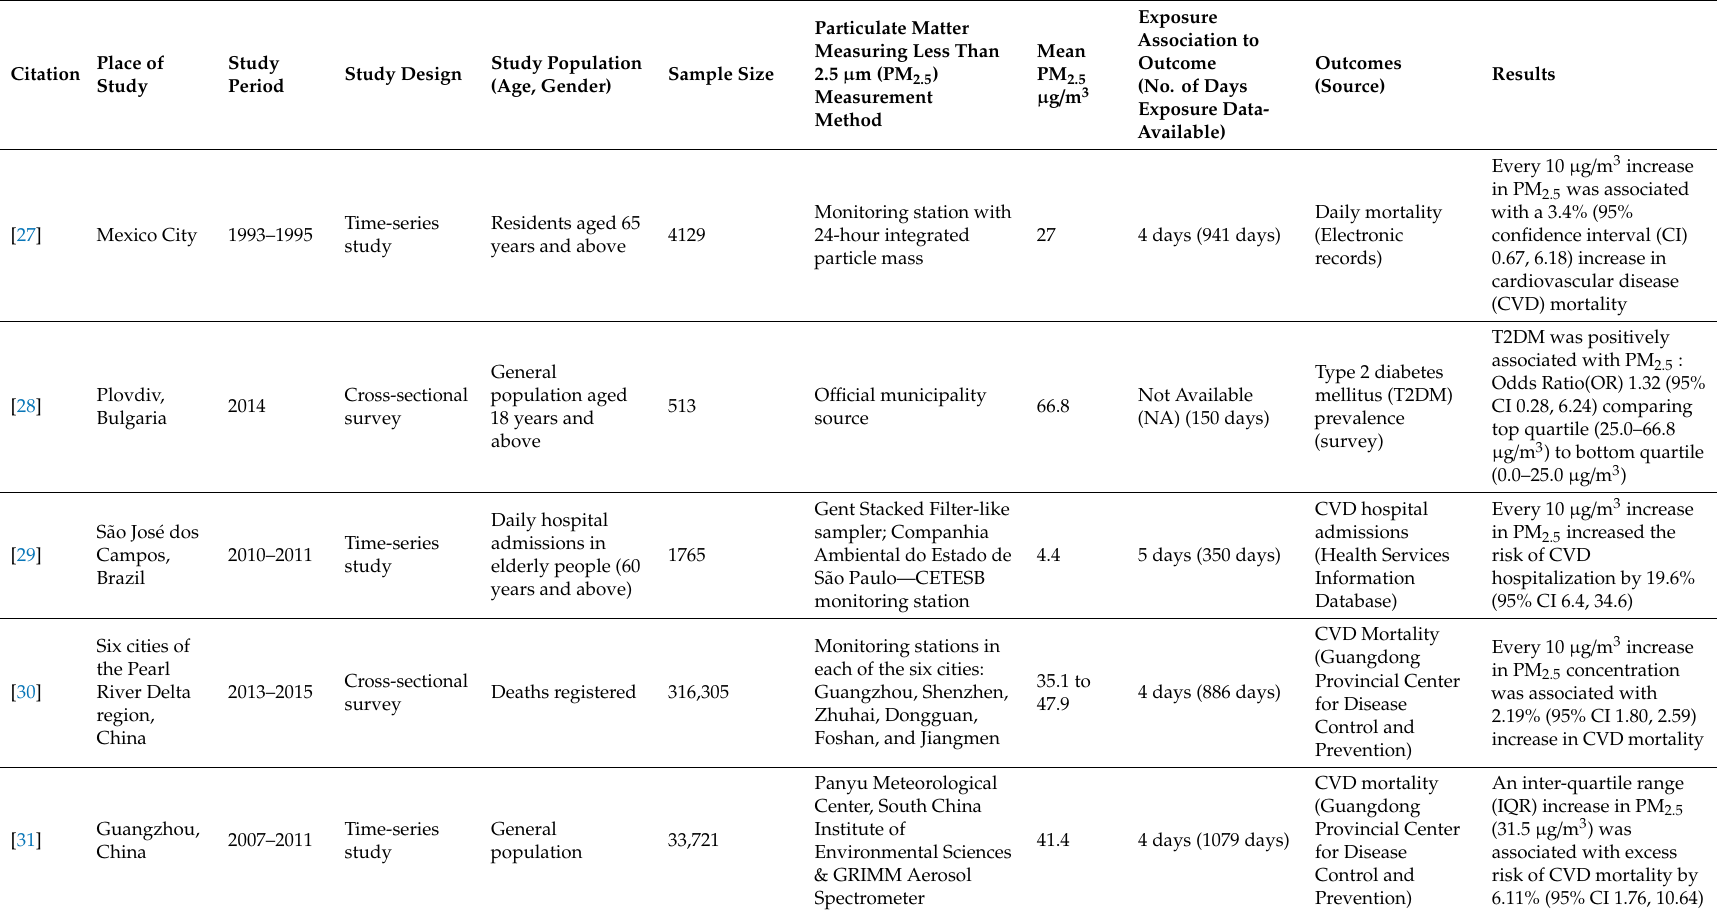
Table 1. Study characteristics, exposure, outcome, and primary results of included studies ( n = 11, listed alphabetically) measuring PM 2.5 exposure less than the annual